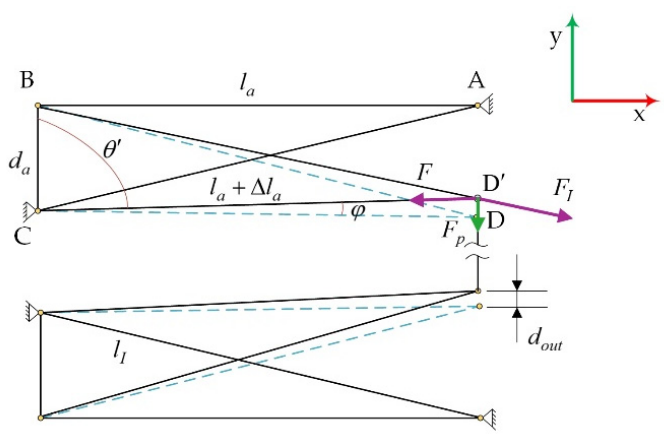
Figure 4. Simplified model of the X module. For triangle 𝐵𝐶𝐷 (cid:4593) , the cosine of ∠𝜃 (cid:4593) can be expressed as: The lengths of the inner frame BD and the outer frame AC stay the same, and their compliance is